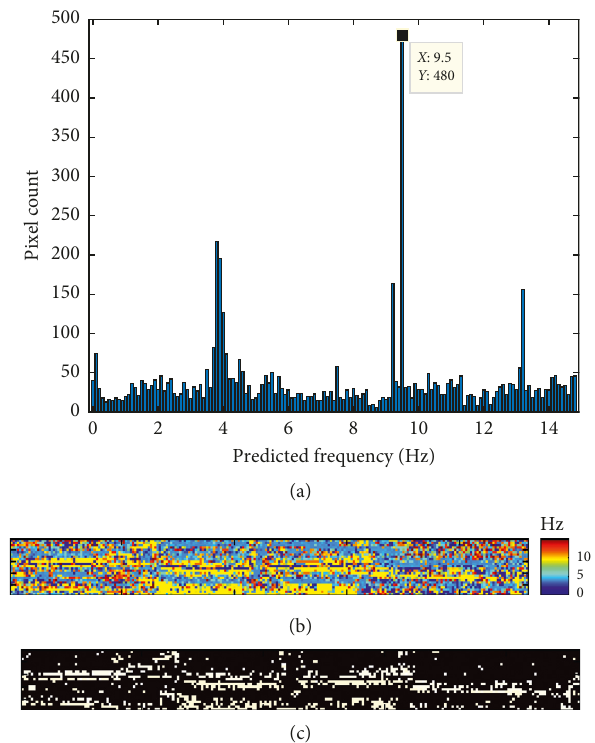
Figure 18: Cantilever steel beam experimental case 2 result from the proposed method. (a) Histogram of predicted frequency distribution. (b) Predicted outputs visualization in their original spatial position. (c) Highlighted pixels predicted as 9.5Hz for verification.